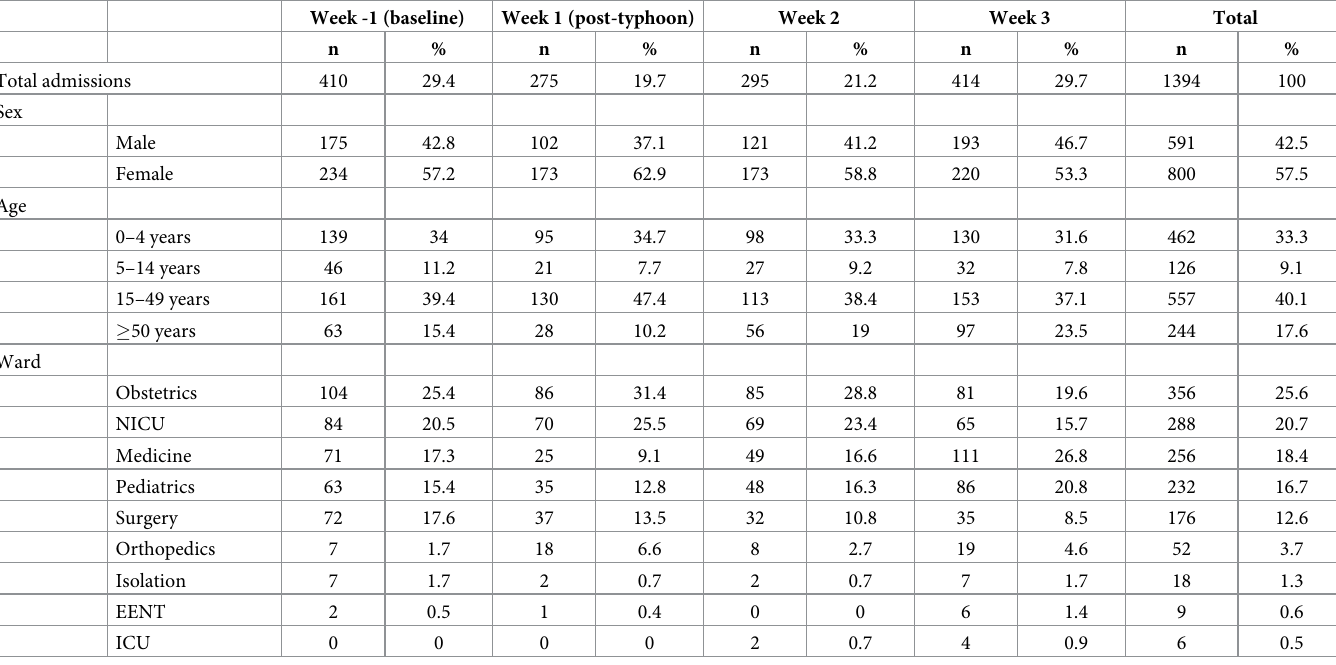
Table 1. Weekly admissions in Eastern Visayas Regional Medical Center in terms of sex, age and ward, one week before and three weeks after Typhoon